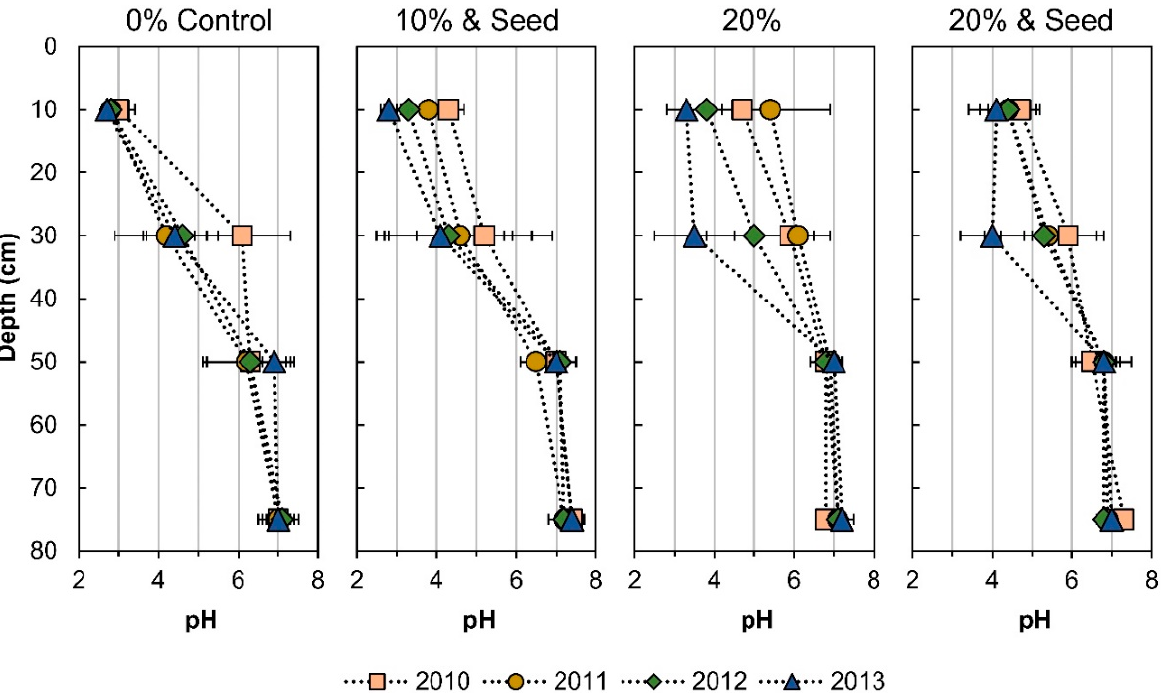
Figure 1. Tailings pH. Error bars are the standard deviation for n = 4 field replicates. Depth markers are the middle of the homogenized sectioned core, reported as cm below the surface.